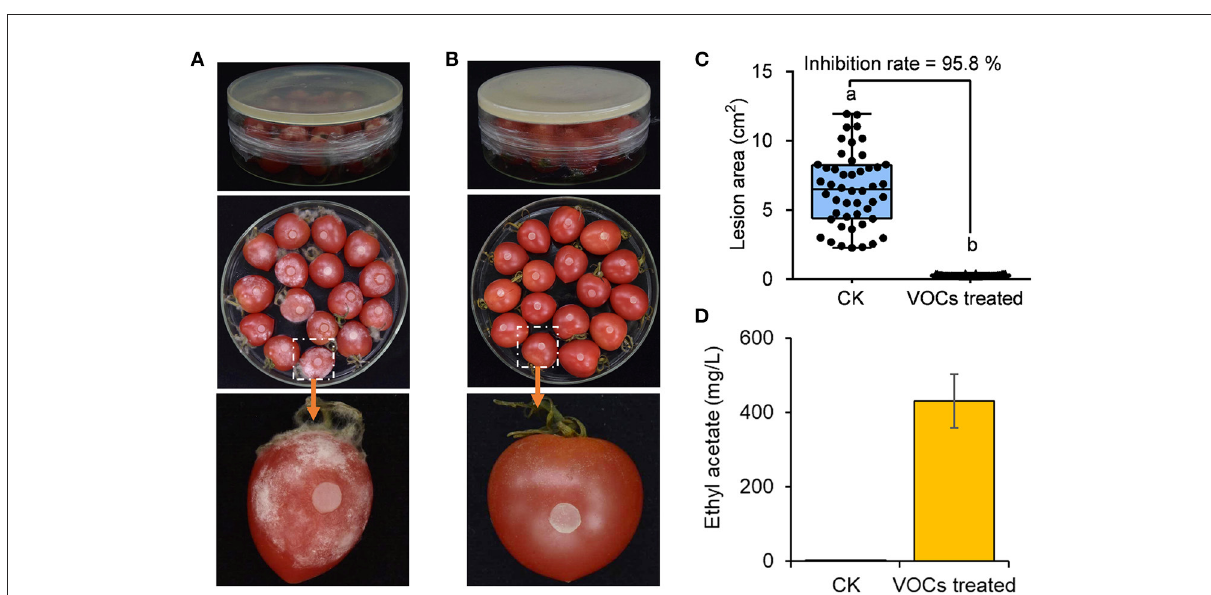
FIGURE7 Evaluation of the efficacy of the VOCs from the yeast strain MP1861 on Phytophthora disease development. (A) Blank control group. (B) Group treated with H. uvarum MP1861 VOCs. (C) Statistics of the areas of 48 lesions on tomato fruit. Different letters, a and b, means a significant difference at the level of p < 0.05. (D) Ethyl acetate contents in the closed Petri dishes. Data are given as the mean values ± SD, n =